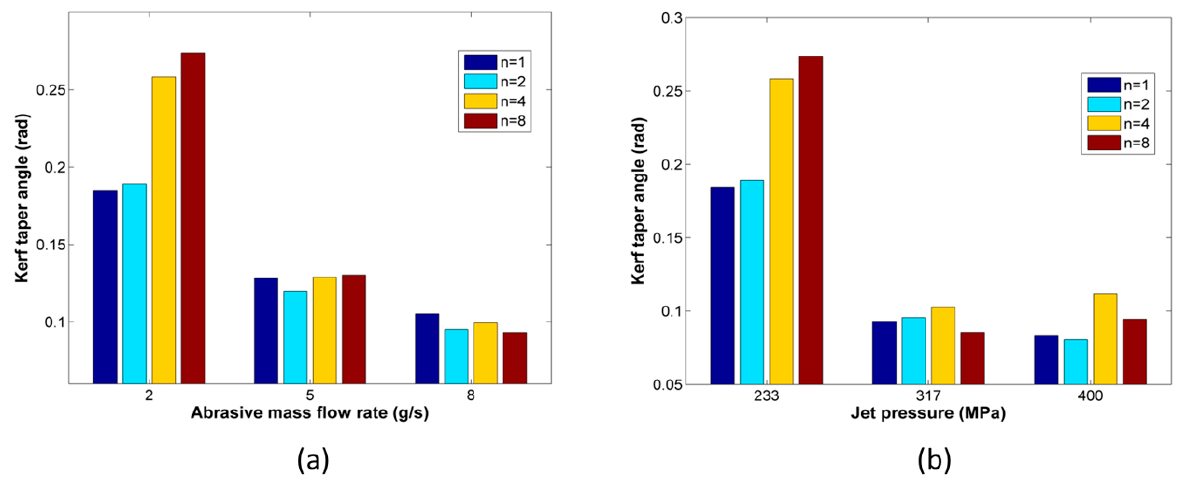
Figure 8. Variation of the kerf taper angle for increasing number of passes in respect to ( a ) abrasive mass flow rate and ( b ) jet pressure.